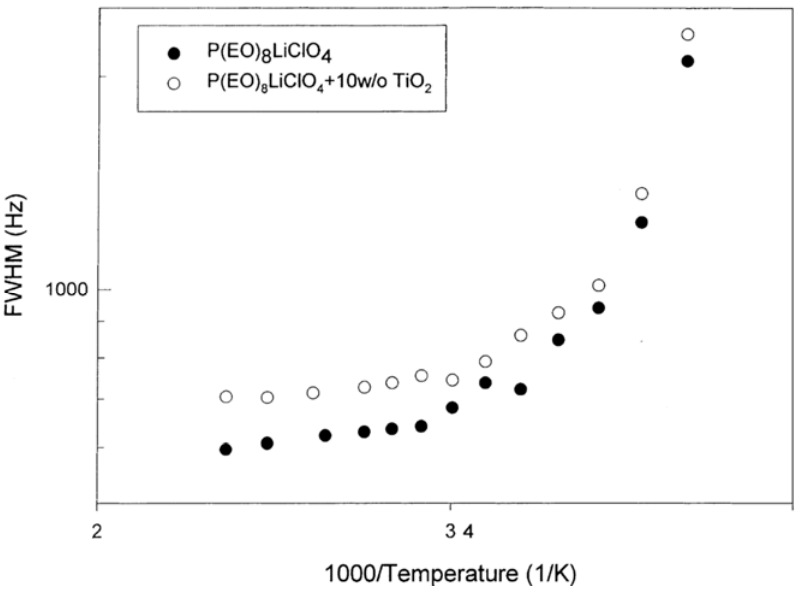
Figure 1. Arrhenius plot of 7 Li NMR linewidth of Li SPE with and without TiO 2 filler